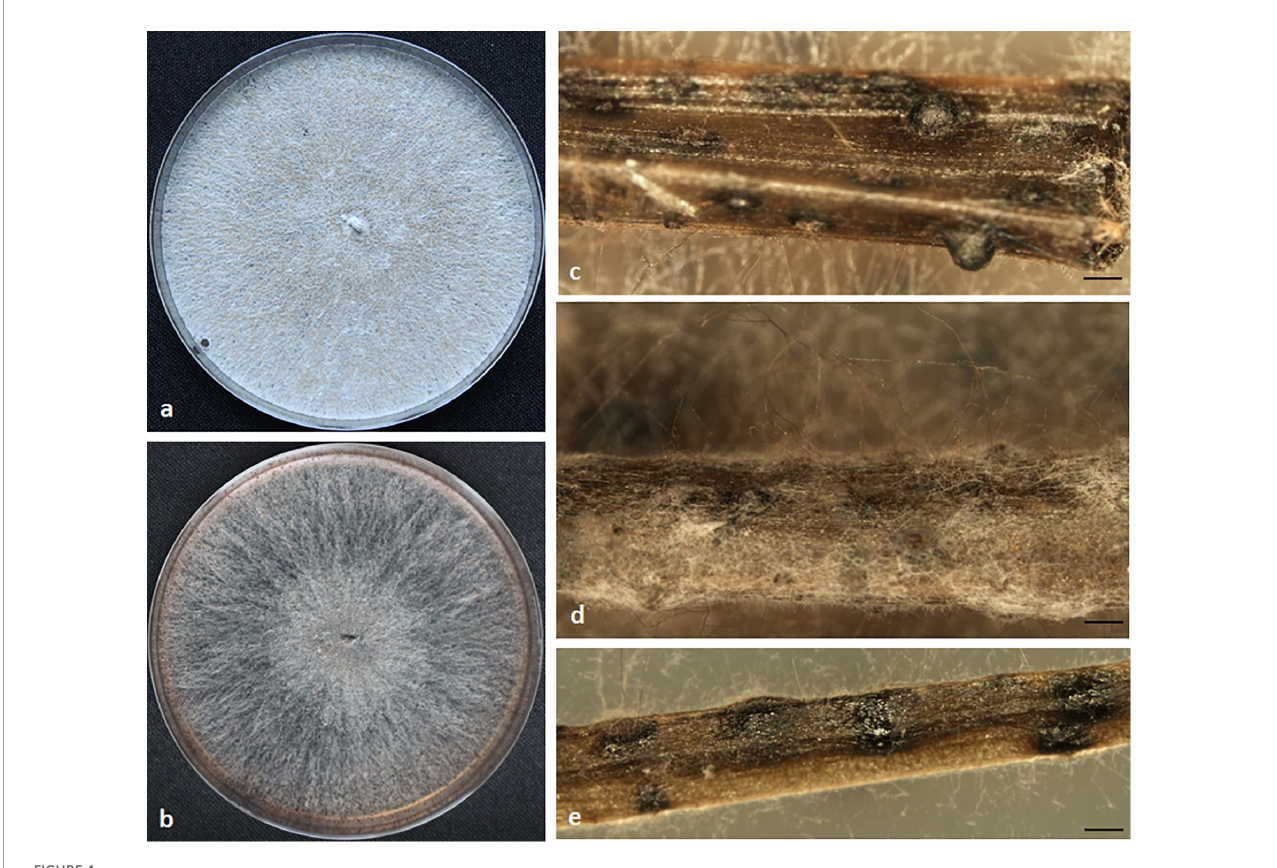
FIGURE4 Morphological characteristics of Diaporthe sp. 1. Colony appearance on potato dextrose agar (PDA) (a) and malt extract agar (MEA) (b) ; sterile conidiomata on pine needle (c,d) and Festuca pruinosa leaves (e) . Scale bar: panels (c–e) = 100 µ m.